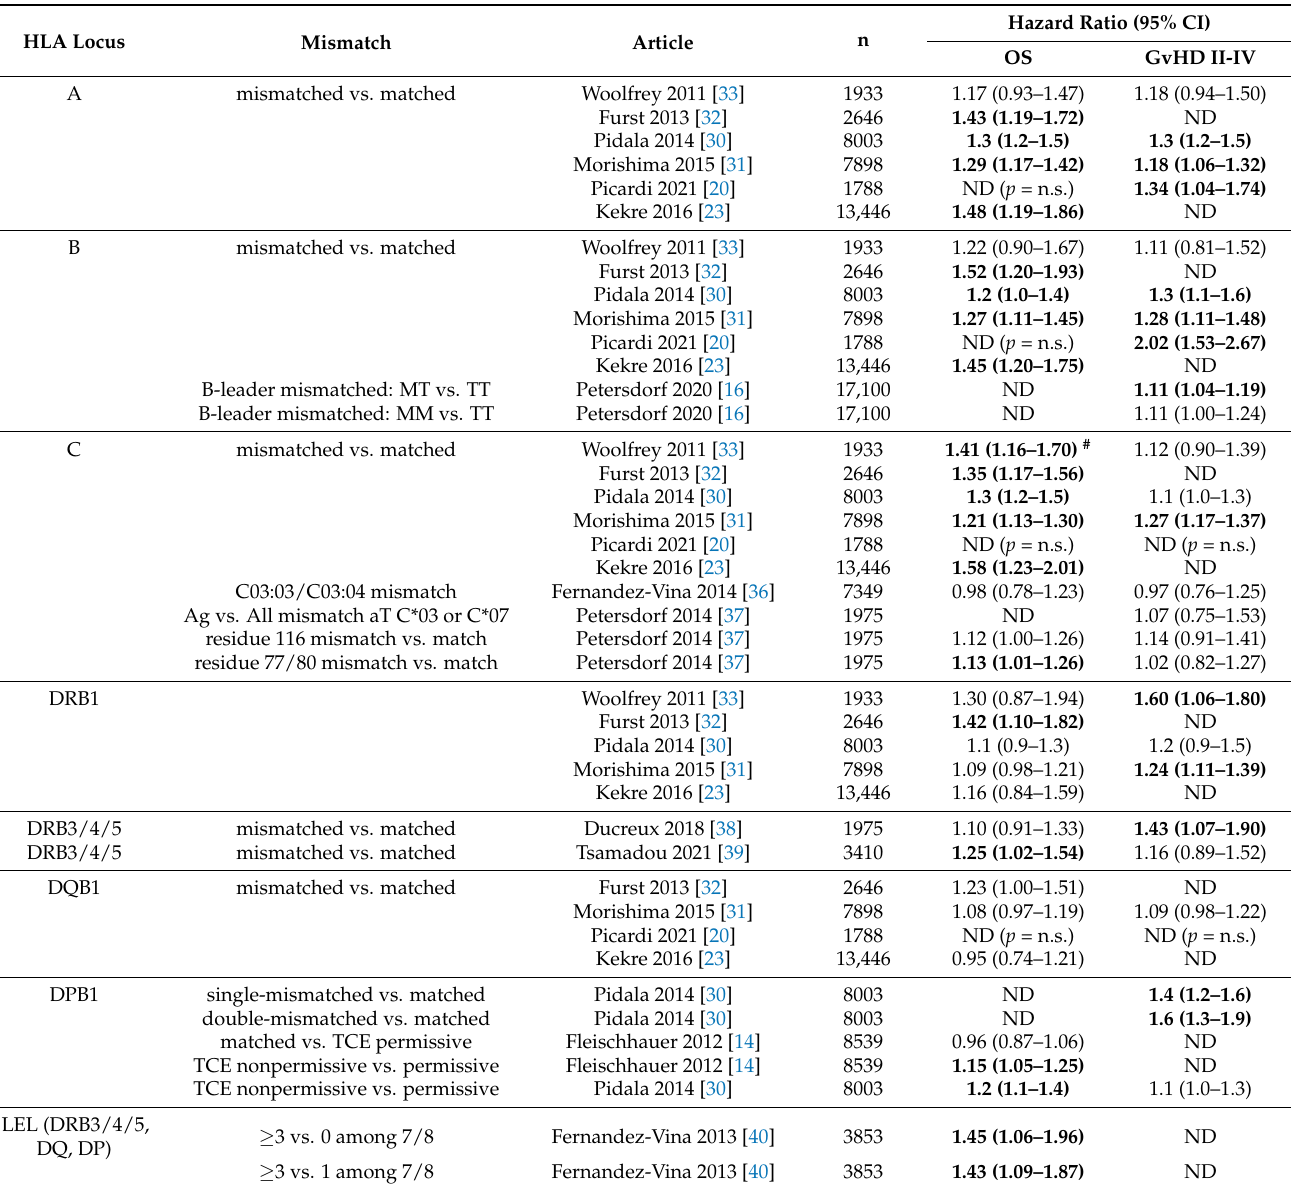
Table 1. Clinical impact of HLA matching in the allo-HSCT setting as reported in most recent relevant